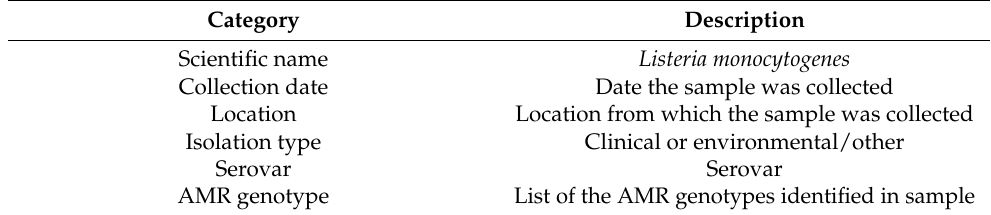
Table 1. Description of data downloaded from